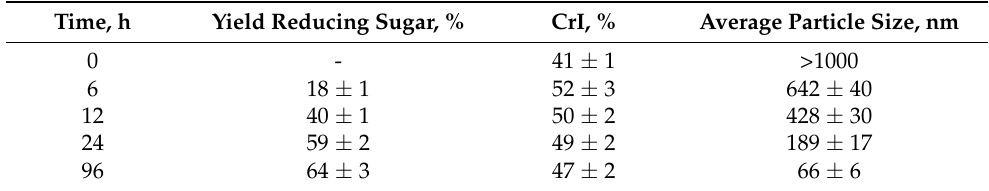
Table 1. The yield of reducing sugars, crystallinity index, and particle size of tapioca starch after enzymatic hydrolysis.